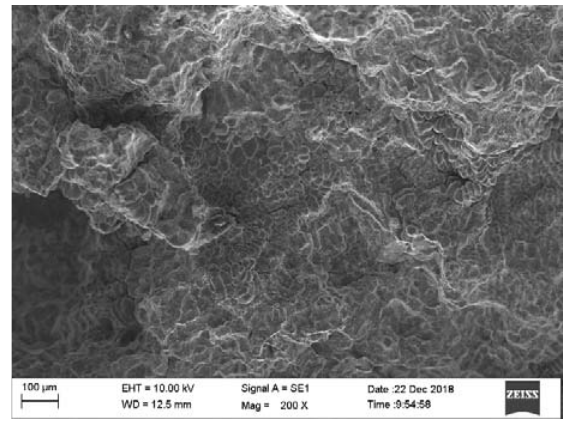
Figure 4: Fracture images of water quenched